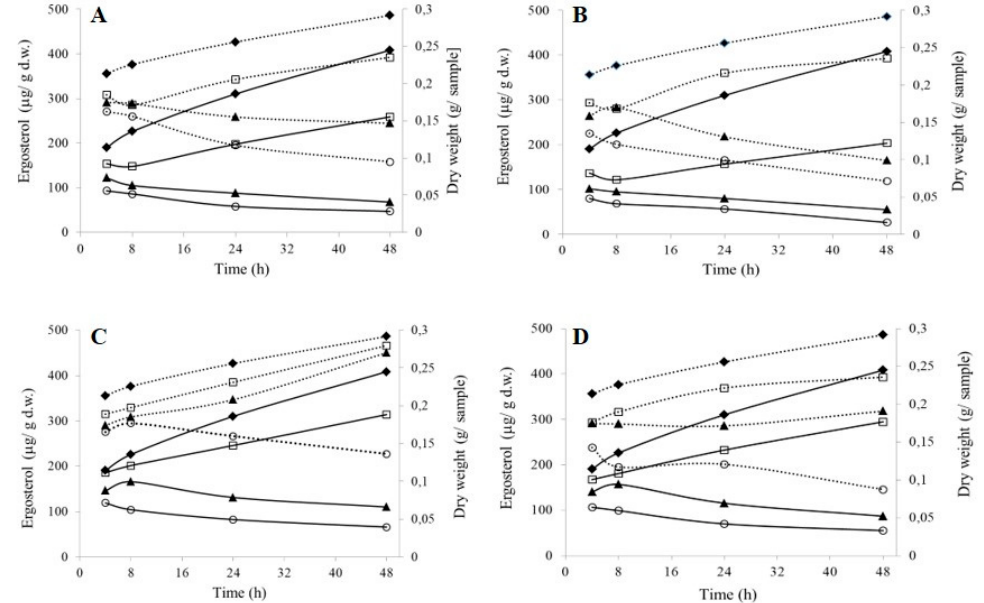
Figure 1. Dry weight (black, solid line) and ergosterol (dotted line) in mycelium following treatment with: cationic gemini surfactants ( A ) pentamethylene-1,5-bis-( N , N -dimethyl- N -dodecylammonium bromide) C5 and ( B ) hexamethylene-1,6-bis-( N , N -dimethyl- N -dodecylammonium bromide) C6; or with non-ionic gemini surfactants ( C ) pentamethylene-1,5-bis-( N -methyl- N -dodecylamine) A5 and ( D ) hexamethylene-1,6-bis-( N -methyl- N -dodecylamine) A6. The results are displayed for ½ MIC (square marker), MIC (triangle marker), 2 MIC (circle marker) and the control sample without the addition of surfactant (rhombus marker).